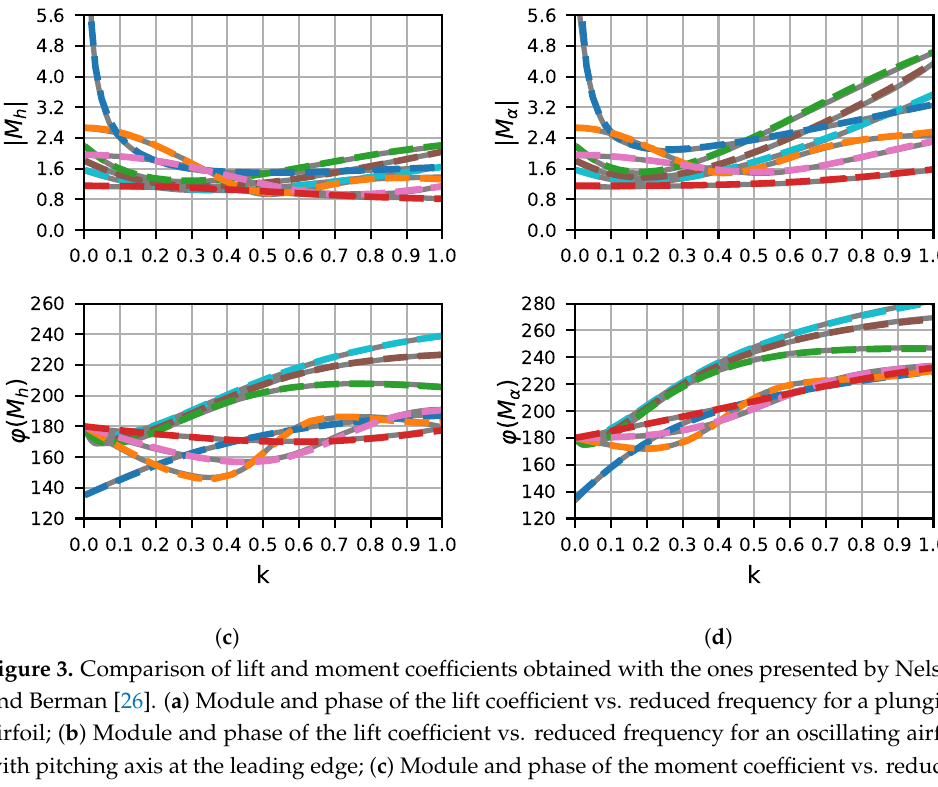
Figure 3. Comparison of lift and moment coefficients obtained with the ones presented by Nelson and Berman [26]. ( a ) Module and phase of the lift coefficient vs. reduced frequency for a plunging airfoil; ( b ) Module and phase of the lift coefficient vs. reduced frequency for an oscillating airfoil with pitching axis at the leading edge; ( c ) Module and phase of the moment coefficient vs. reduced frequency for a plunging airfoil; ( d ) Module and phase of the moment coefficient vs. reduced frequency for an oscillating airfoil with pitching axis at the leading